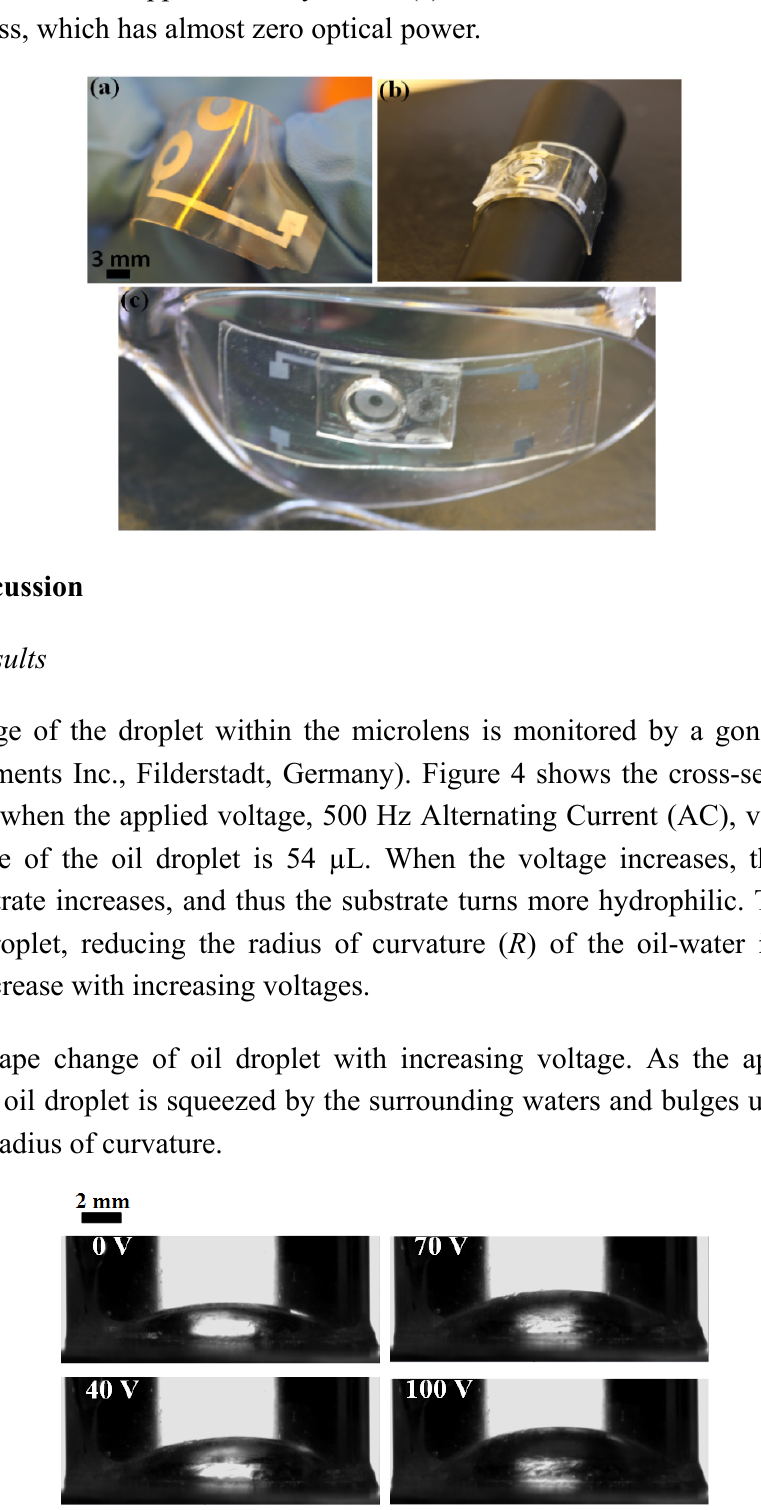
Figure 3. Demonstration of the flexible PDMS lens structure: ( a ) Bending a PDMS substrate (already coated with Al electrode, SU-8 dielectric layer and Teflon coating); ( b ) a flexible EWOD lens wrapped on a cylinder; ( c ) a flexible EWOD lens bonded with a